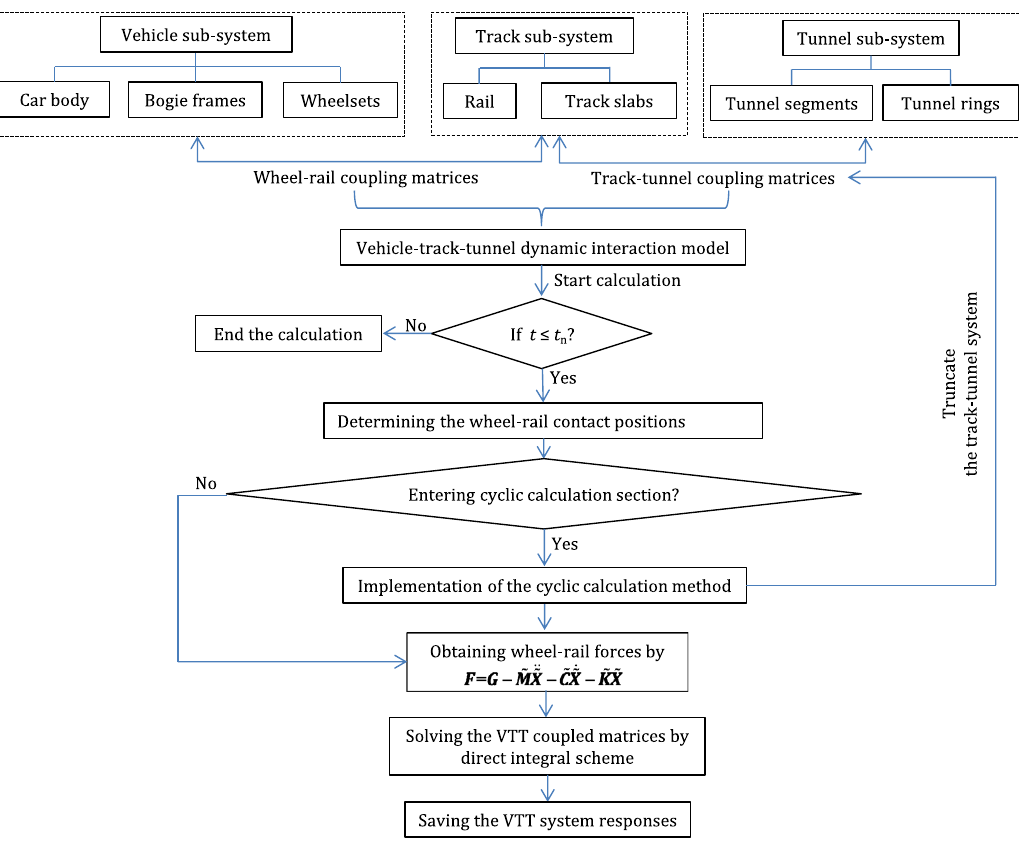
Fig. 6 The modeling framework for characterizing vehicle–track–tunnel dynamic